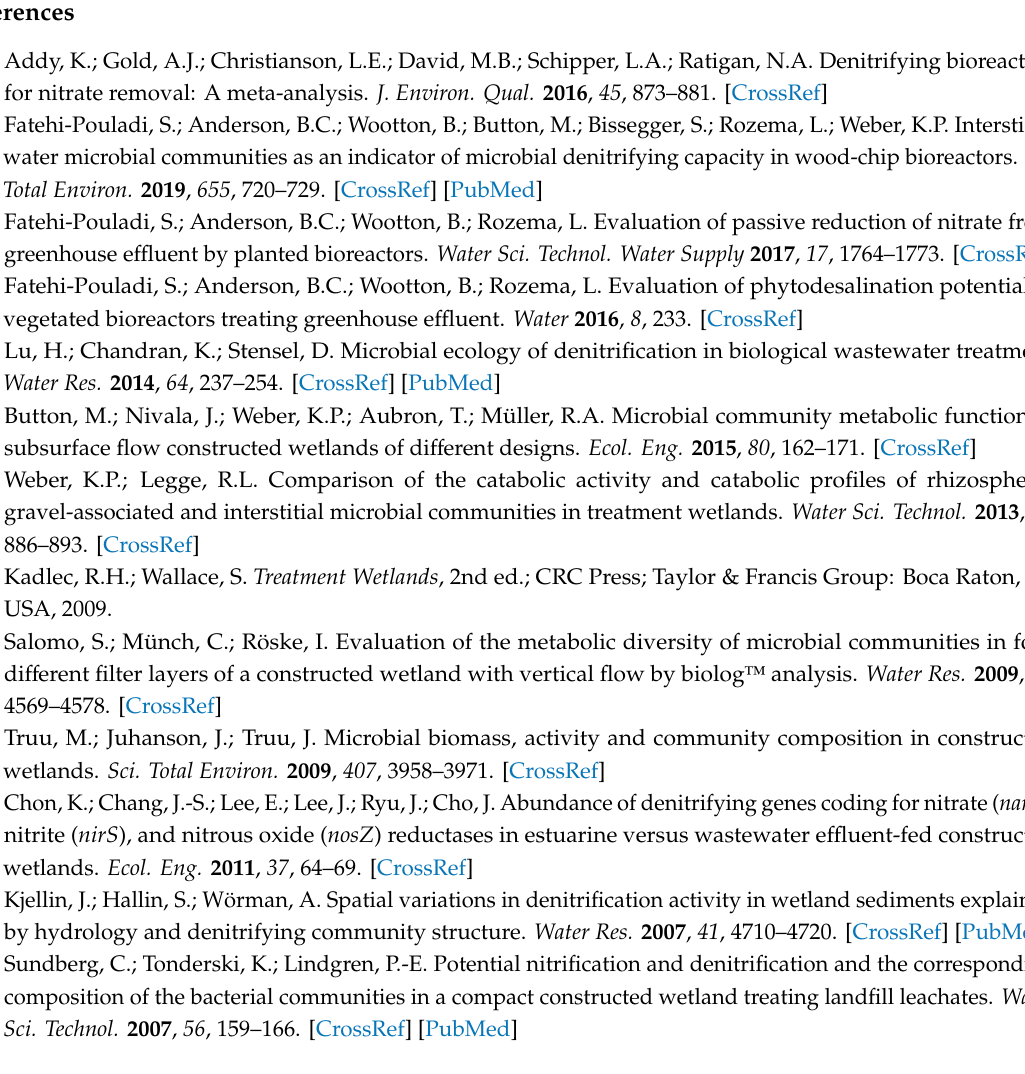
Figure S1: Multivariate analysis for wood-chip and root samples based on the carbon utilization patterns (CSUP). Figure S2: Multivariate analysis for the interstitial water samples based on the carbon utilization patterns (CSUP). Figure S3: Temporal change of relative bacterial composition at genus level in the S. tabernaemontani reactor’s interstitial water samples. Figure S4: Temporal change of relative bacterial composition at the genus level in the T. angustifolia reactor’s interstitial water samples. Figure S5: Temporal change of relative bacterial composition at the species level in the T. angustifolia reactor’s interstitial water samples. Figure S6: Temporal change of relative bacterial composition at the genus level in the unplanted reactor’s interstitial water samples. Figure S7: Relative bacterial composition at the genus level in the influent sample collected on Day 442. Figure S8: Heatmap and dendrogram of the biofilm from roots, based on the abundance of the microbial community at the genus level. Figure S9: Relative bacterial composition at a: the genus level, and b: at the species level in the biofilm root samples. Table S1: The total number of reads per sample included in this study. Woodchip and root samples were taken in duplicate and